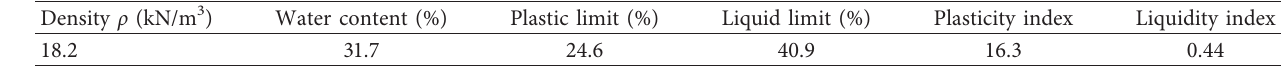
Table 1: Coastal soft soil physical properties.